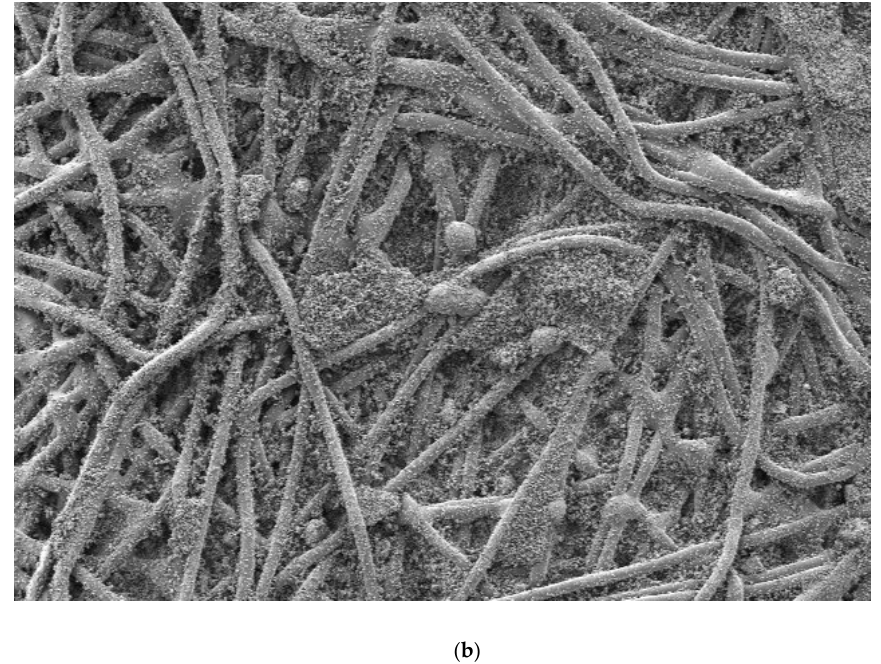
Figure 11. 1000 times magnified photos of filter media ( a ) before and ( b ) after the experiment.